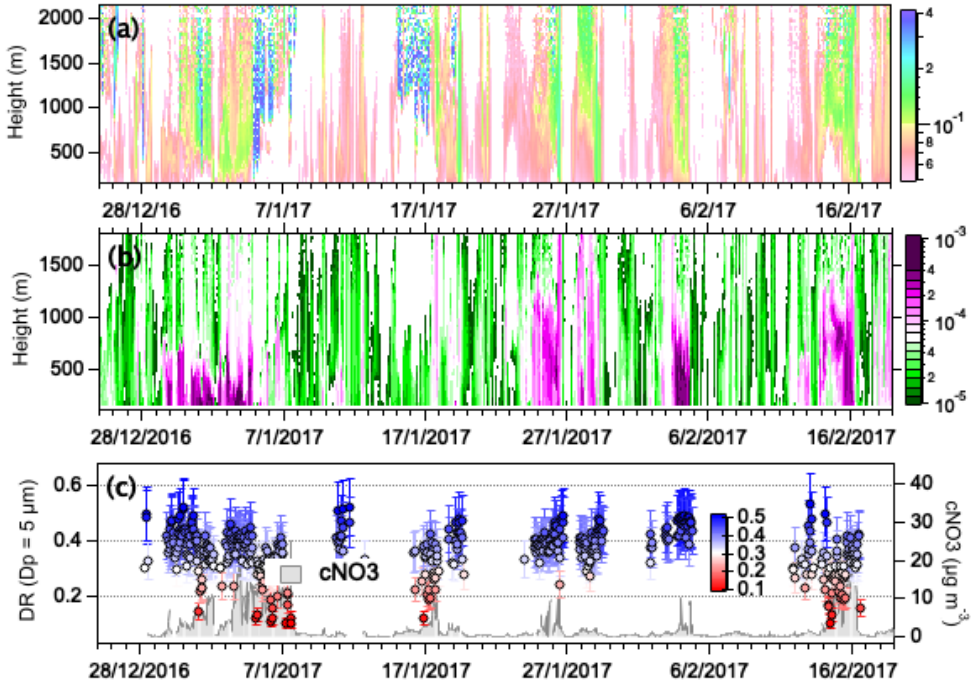
Figure 6. Vertical distribution of volume depolarization ratio (@532nm) (a) , extinction coefficient of dust particles derived from lidar observation (b) and variability of δ value of mineral dust particles and NO − in coarse mode aerosols (c) as a function of time. Here we 3 choose the particles at a size of 5µm to indicate the mineral dust particles, marked as δ Dp = 5